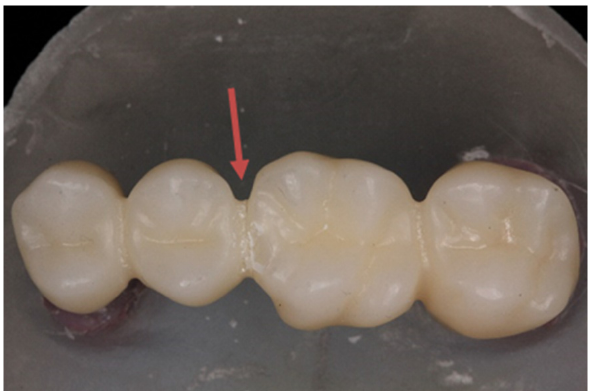
Figure 1. Exemplary picture of prevailing failure mode by cracking in the connector area (arrow).